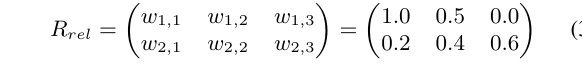
Figure 7. An example of the relative interests of stakeholders (black) and the relevance of changes (green) with respect to the real world and the city models.